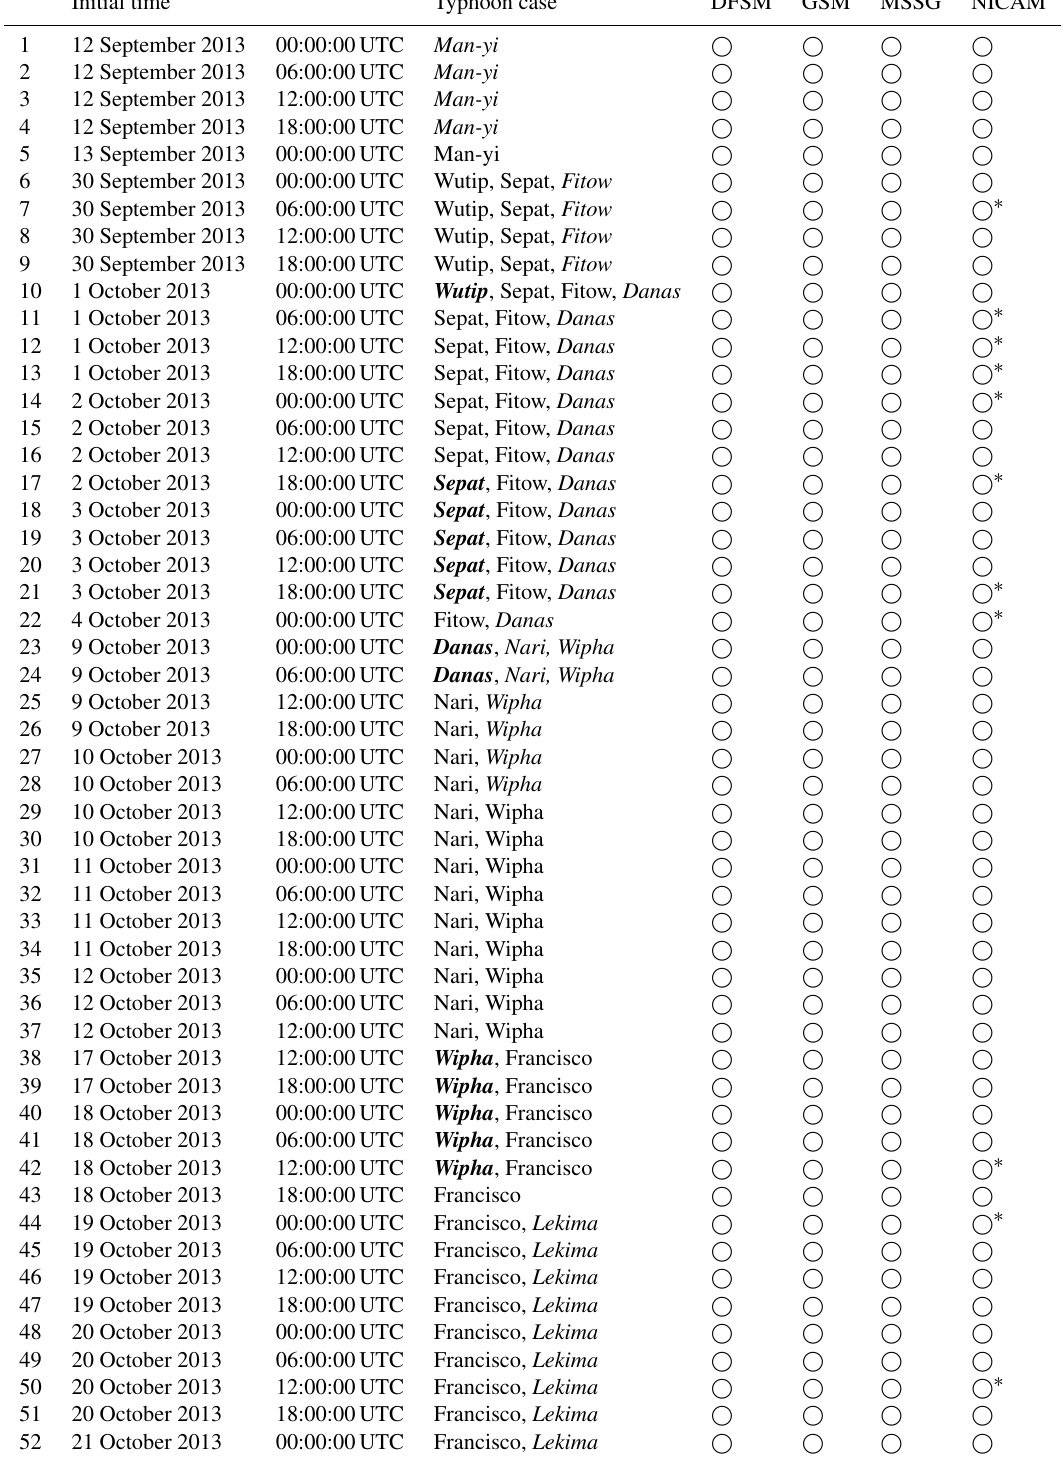
Table 1. List of initial times for stage 1 of TYMIP-G7. Typhoon cases in italic font are weaker than a tropical storm and those in bold italic font are extratropical